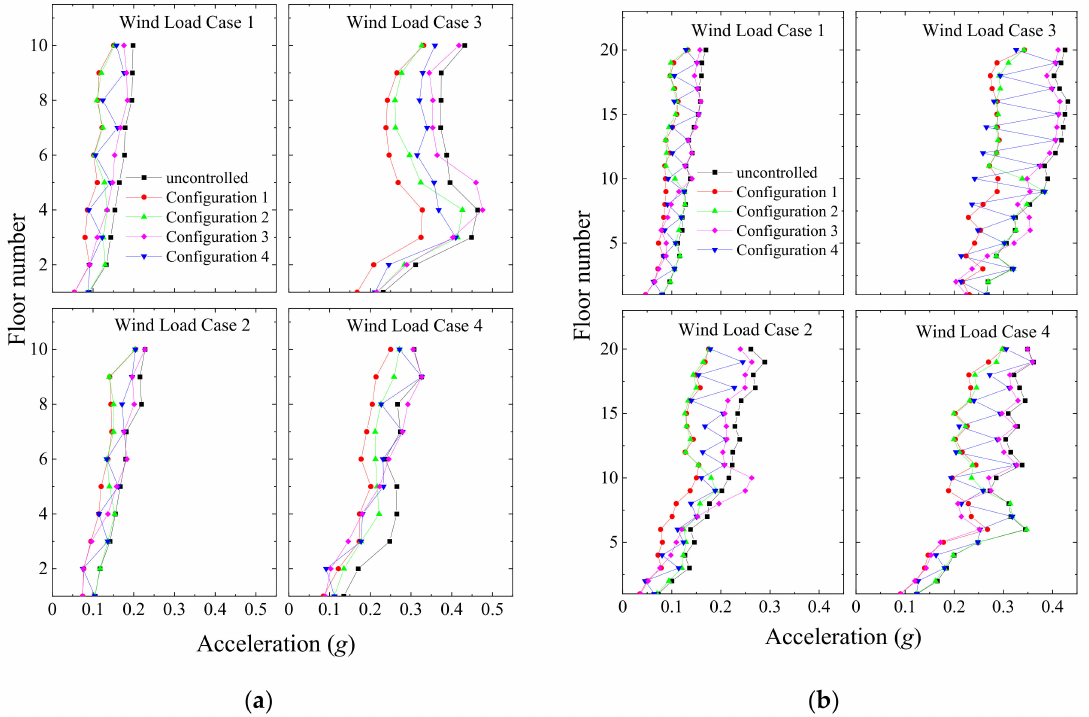
Figure 30. Peak floor acceleration under wind excitation in different damper configurations in: ( a ) a coupled stiff building and ( b ) a coupled flexible building under semi-active control of the MR